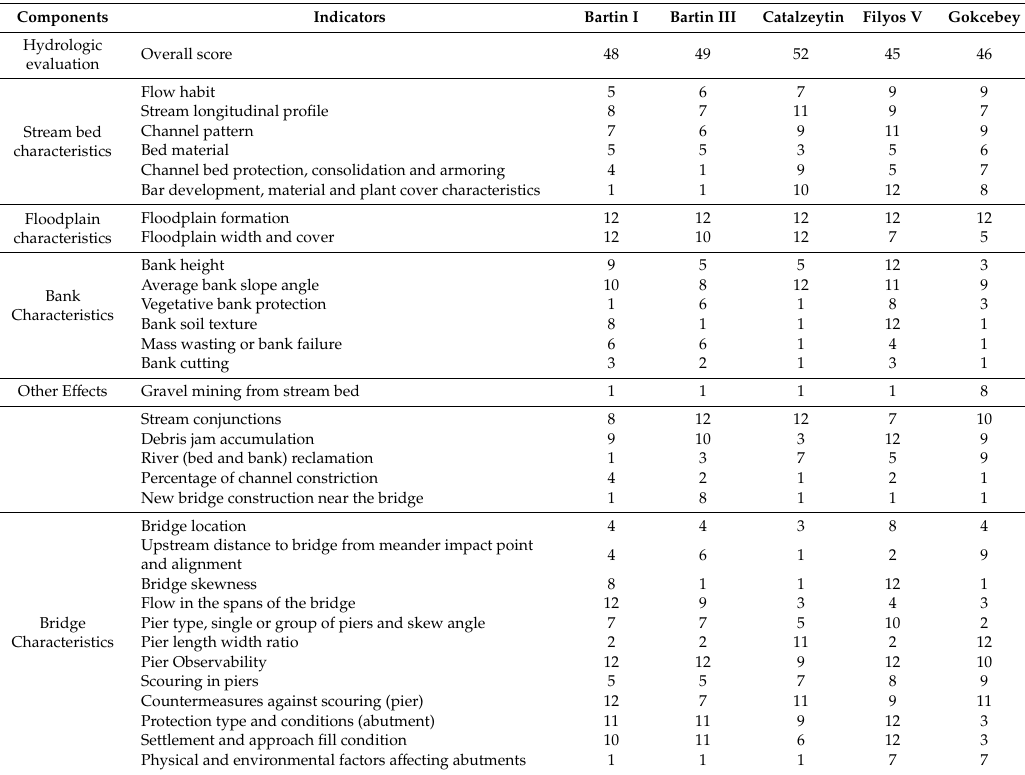
Table 13. Grading of river bridges in regard to hydraulic